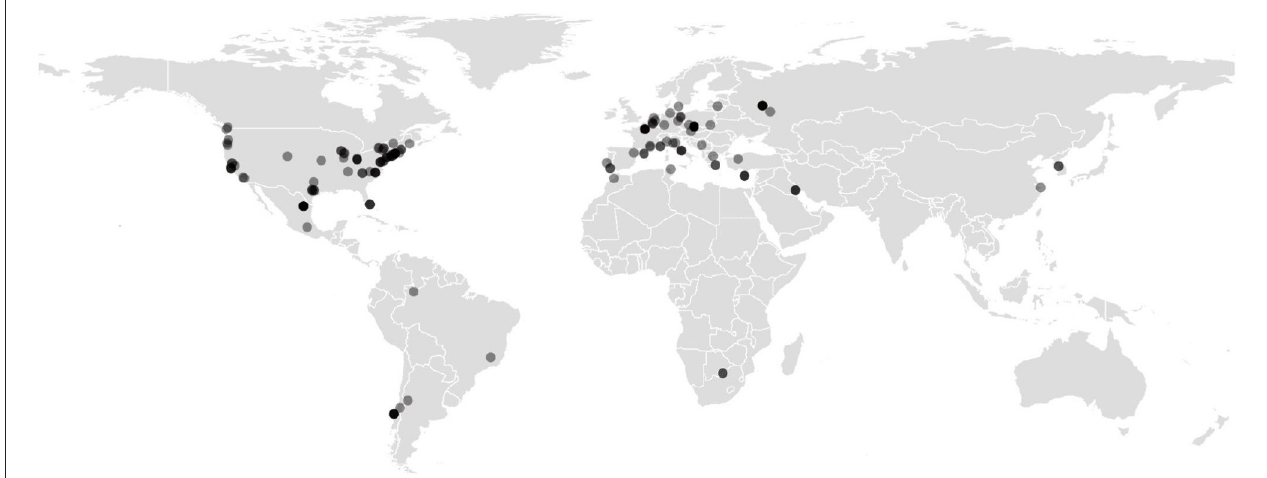
FIGURE 3 | The paradox of ubiquity. The Indian mealmoth ( Plodia interpunctella ) like many indoor species is a cosmopolitan pest with an extraordinarily broad geographic range, as shown here based on observations made by citizen scientists using the iNaturalist platform. Though its biogeographic history has never been studied, this moth is often described as having evolved from tropical regions and then having spread around the world via commercial ocean freight shipments (though its biogeographic history has never been studied; Cox, 1978; Schulten and Roorda, 1984). Because it is soft-bodied, it is unlikely to be recovered from archaeological sites. Like many grain pests, it may have colonized human settlements along with the domestication of crops and the storage of grain. The paradox with this moth, as with many indoor species, is how it could have spread so widely and yet failed to diverge or even speciate. This paradox has layers; the Indian mealmoth is host to specialist parasites, including baculoviruses. Have they diverged among regions? We do not know. One intriguing possibility is that indianmeal moth baculoviruses, by shuffling genetic material into and out of hosts ( Gilbert et al., 2014; Raymond and Erdos, 2022) might have actually facilitated evolution and local adaptation in Indian mealmoths. Testing whether this has occurred as well as the many predictions about where the diversity of novel lineages is greatest (in big, hot, cities) or least (in smaller cities and or regions with more movements of grains) is a straightforward project that awaits an interested